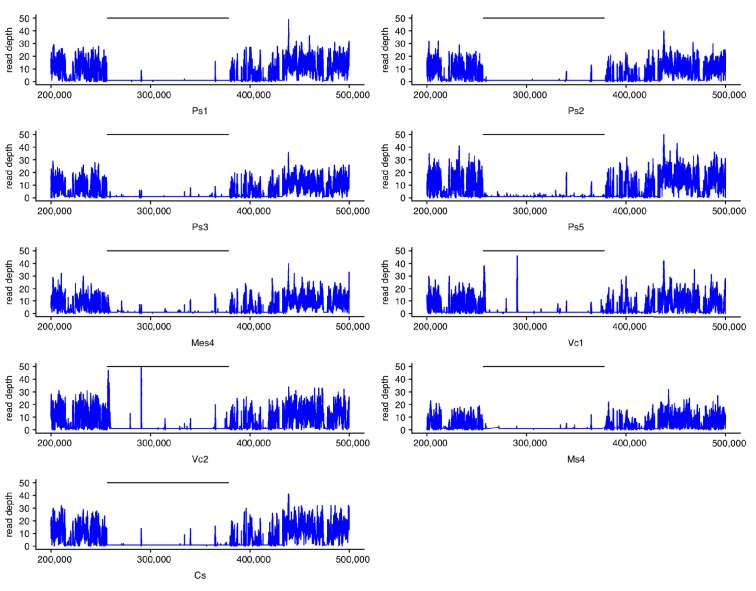
Reads from winged individuals of different biotypes do not map to the wingless-specific region.The x-axis shows position along the api wingless scaffold. Read depth is absolute, and differs among individuals. A solid black line indicates the wingless-specific region. Abbreviations: Mes: Melilotus officinalis, Tp: Trifolium pratense, Lap: Lathyrus pratensis, Ps: Pisum sativum, Ms: Medicago sativa, Os: Ononis spinosa, Mes: Melilotus suaveolens, Vc: Vicia cracca, Cs: Cytisus scoparius..